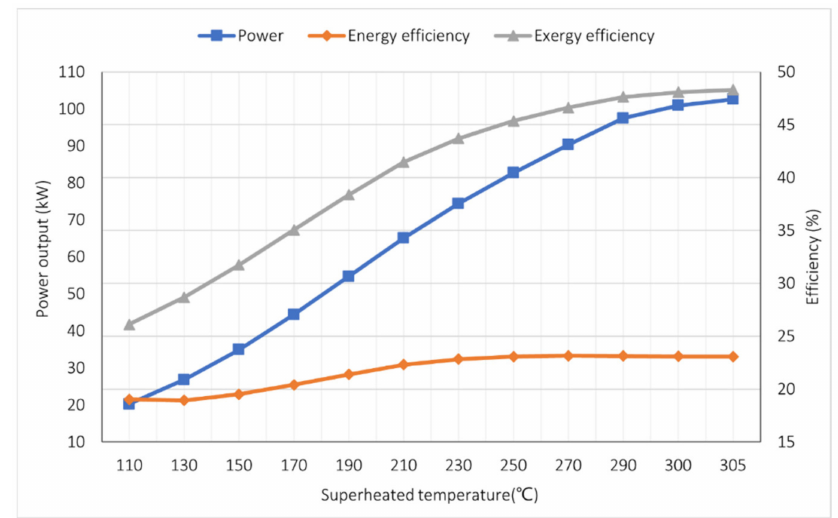
Figure 12. Influence of the superheated temperature on the R152a